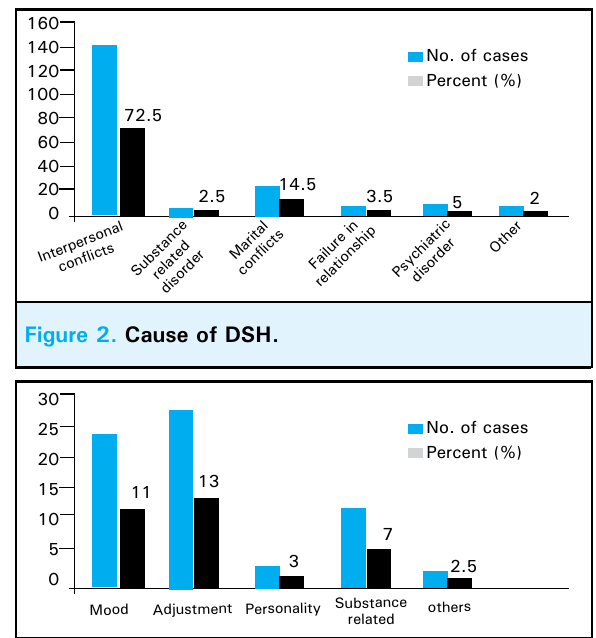
Figure 3. types of Psychiatric